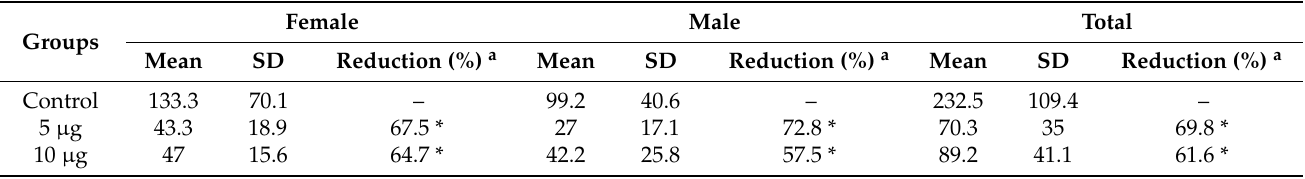
Table 2. Worm numbers from challenged goats in the trials. At the end of the experiment (day 140), the worm numbers in the goat’s abomasa were counted. Mean worm numbers (with standard deviations, SD) of individual groups were